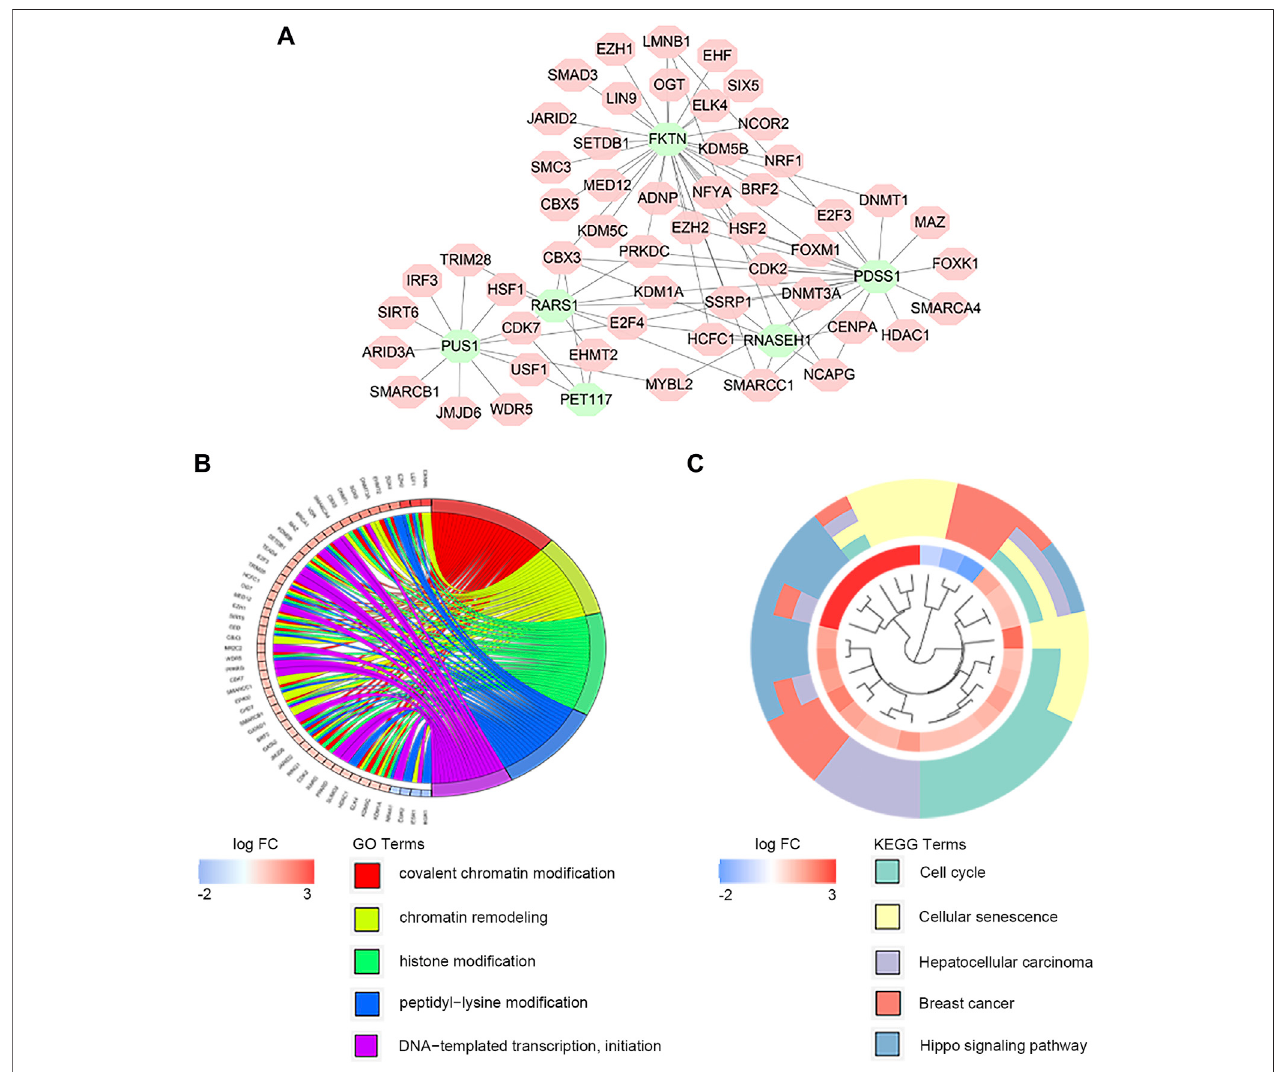
FIGURE 5 | Co-expression of transcription factors and key LMRGs. (A) Regulatory network of key LMRGs and transcription factors. (B) GO enrichment results of transcription factors. (C) KEGG enrichment results of transcription factors.